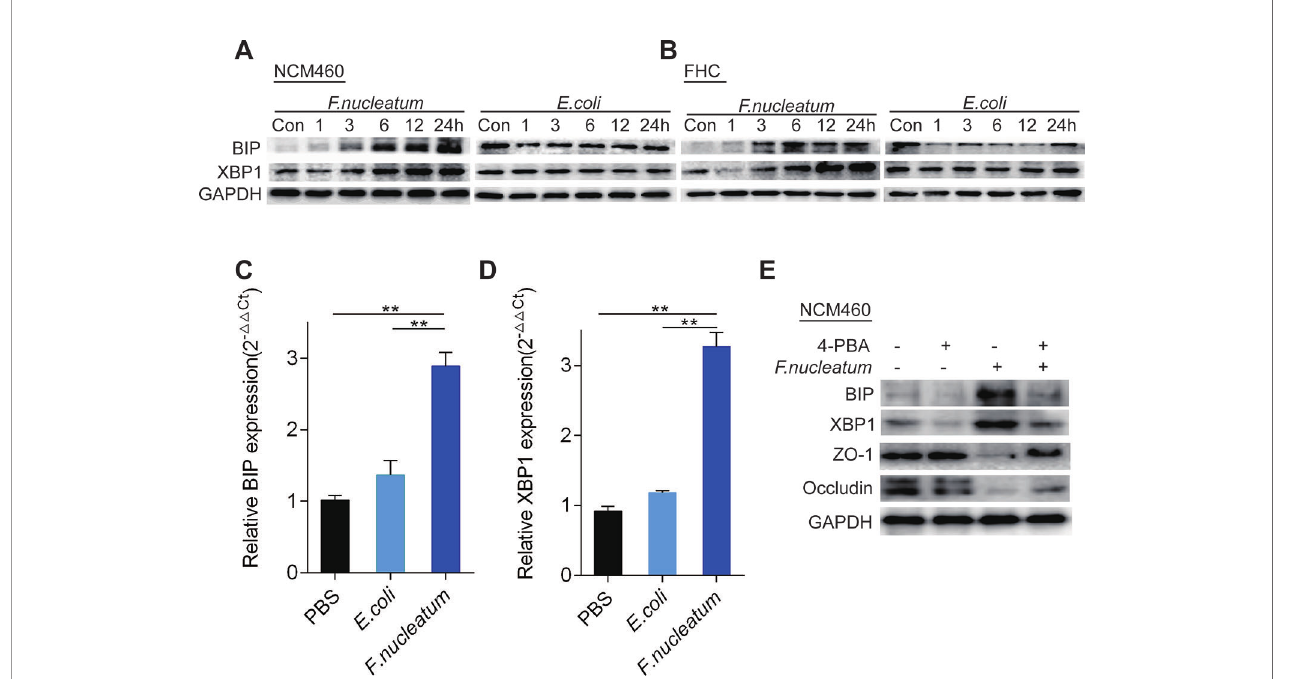
FIGURE 3 | Fusobacterium nucleatum activates the endoplasmic reticulum (ER) pathway and damages mucosal barrier-associated proteins via ER signaling in intestinal epithelial cell lines. (A, B) Western blotting was performed to measure BIP and XBP1 expression in NCM460 cells (A) and FHC cells (B) cocultured with F. nucleatum , Escherichia coli , or phosphate-buffered solution (PBS) (Control, Con). (C, D) The mRNA expression of BIP (C) and XBP1 (D) was measured in NCM460 cells cocultured with F. nucleatum, E. coli , or PBS (* P < 0.05, ** P < 0.01; unpaired Student ’ s t test; the error bars indicate the SDs). (E) Western blotting was performed to measure BIP, XBP1, ZO-1, and occludin expression in NCM460 cells cocultured with F. nucleatum , 4-phenyl butyric acid (4-PBA), or